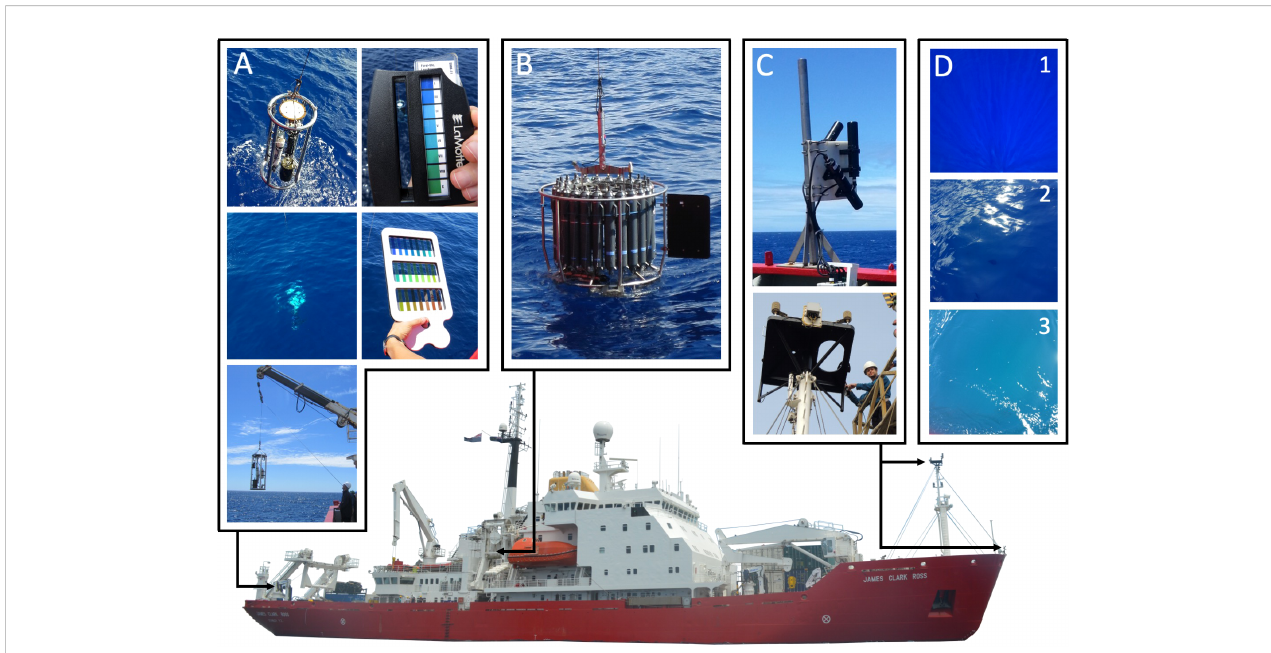
FIGURE 2 Instrumentation used on-board the RRS James Clark Ross . (A) Secchi disk attached to the optics rig and deployed from the aft-deck winch, with the Forel-Ule colour scales, the LaMotte scale used on AMT23-28, and that described in Novoa et al. (2014) and used on AMT25-28. (B) Conductivity, Temperature and Depth (CTD) Niskin Rossette used to collect water samples of Chl-a, measure PAR and beam attenuation, deployed on the CTD winch located towards the centre of the ship. (C) Satlantic Hyperspectral (HyperSAS) radiometer set-up (photos from AMT23), with the two radiance sensors positioned on the very bow of the ship (and tilt and heading sensor is shown vertically), and the downwelling irradiance sensor positioned vertically on the met-platform on the ship ’ s foremast (bottom fi gure showing it being attached on AMT23). (D) Photos of water colour collected on AMT23, in (1) the centre of the South Atlantic gyre, (2) the edge of the North Atlantic gyre, and (3) in the South Subtropical Convergence Zone, illustrating visual transitions from blue to blue-green